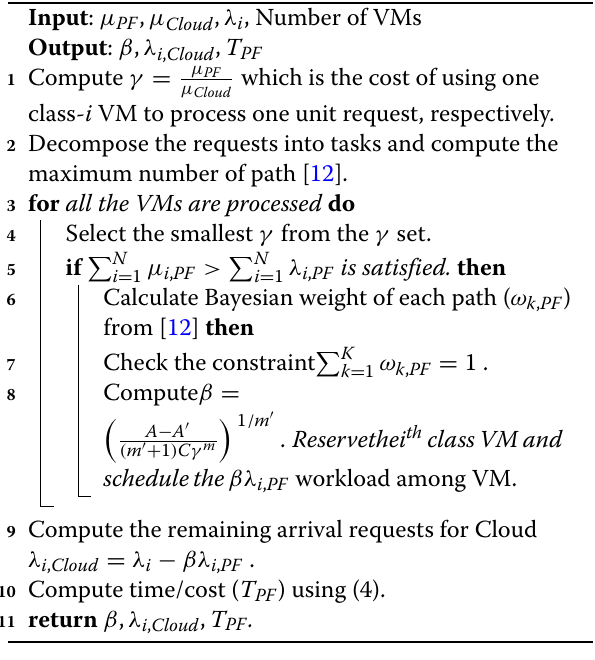
Algorithm 1: Workload scheduling in pre-fetcher with access probability β